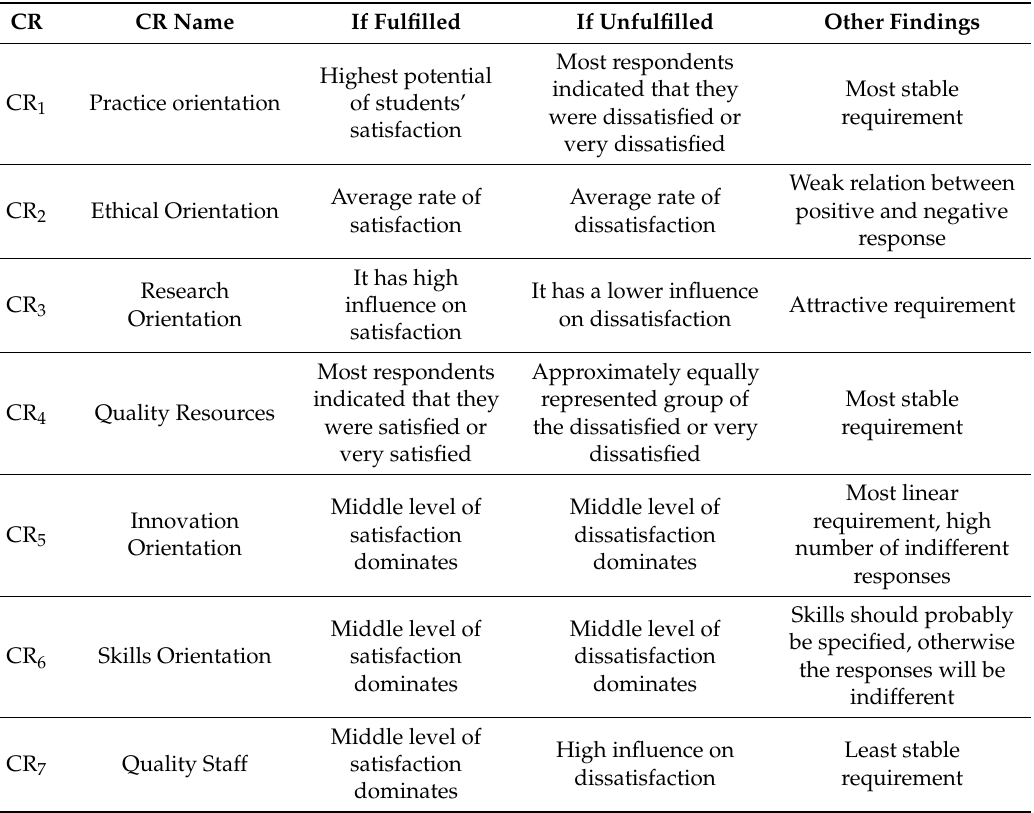
Table 7. Effect of requirement fulfilment or unfulfillment on